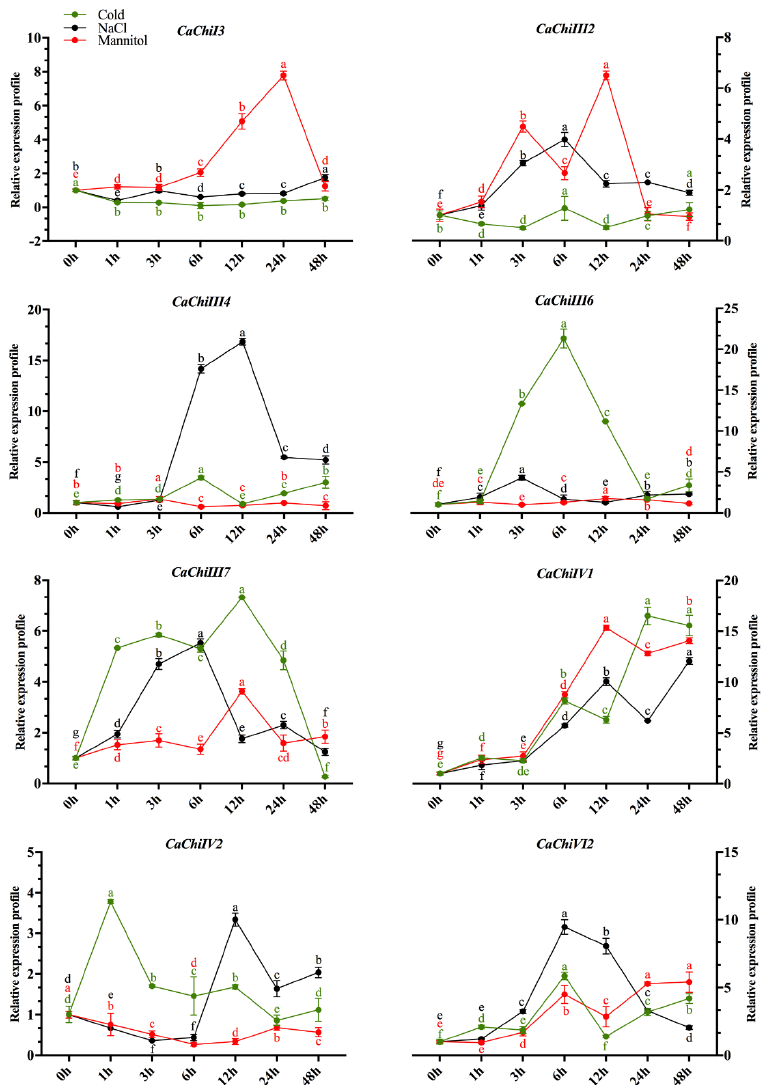
Figure 8. Expression profiles of CaChi genes in response abiotic stresses. The inducible expression patterns performed by qRT-PCR under Sodium chloride (NaCl) and Mannitol. Mean values and SDs for three replicates are shown. Small letters (a–e) represent significant differences ( p < 0.05).